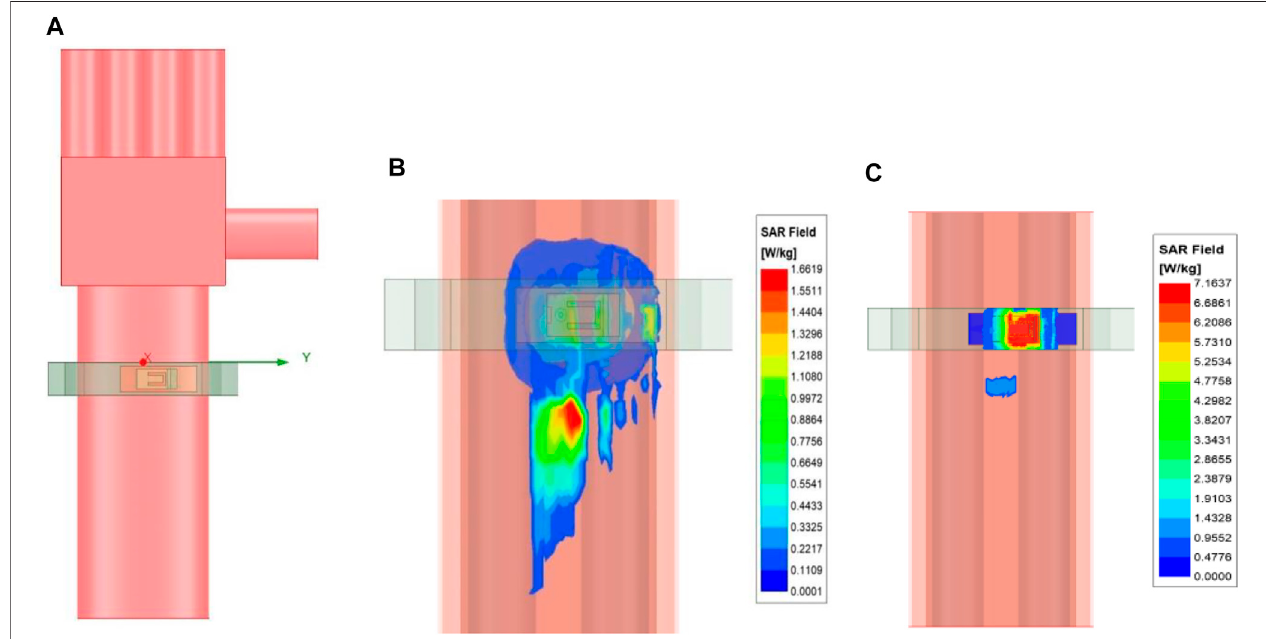
FIGURE 7 | Average SAR values of the human wrist wearing the LM antenna. (A) Antenna worn on the human wrist, (B) average SAR values of the human wrist at 2.4 GHz, and (C) average SAR values of the human wrist at 5.8 GHz.